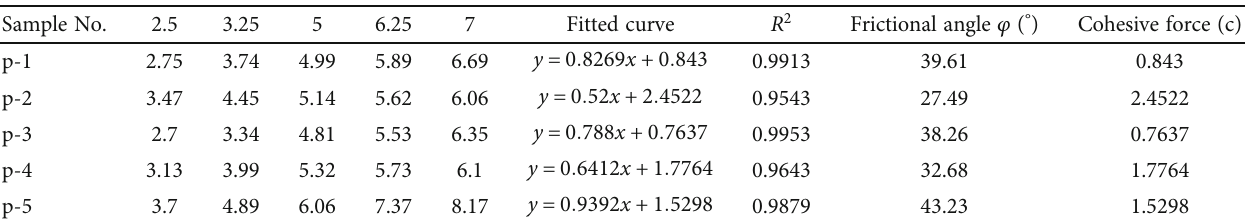
Table 3: Basic mechanical parameters of discontinuities.